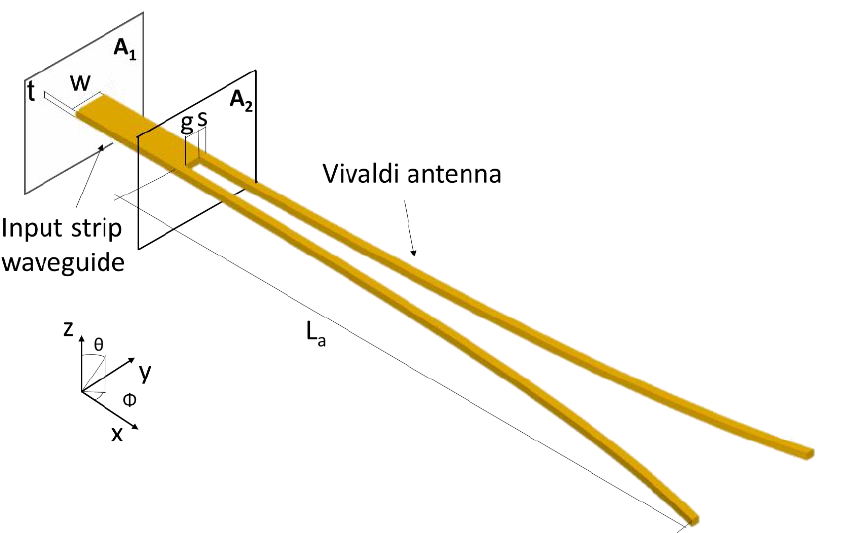
Figure 1. Scheme of the dielectric Vivaldi antenna directly coupled to a strip waveguide. The antenna is composed of silicon nitride and, to investigate its radiation properties, it is embedded into a homogenous medium with refractive index n SiO2 = 1.445.